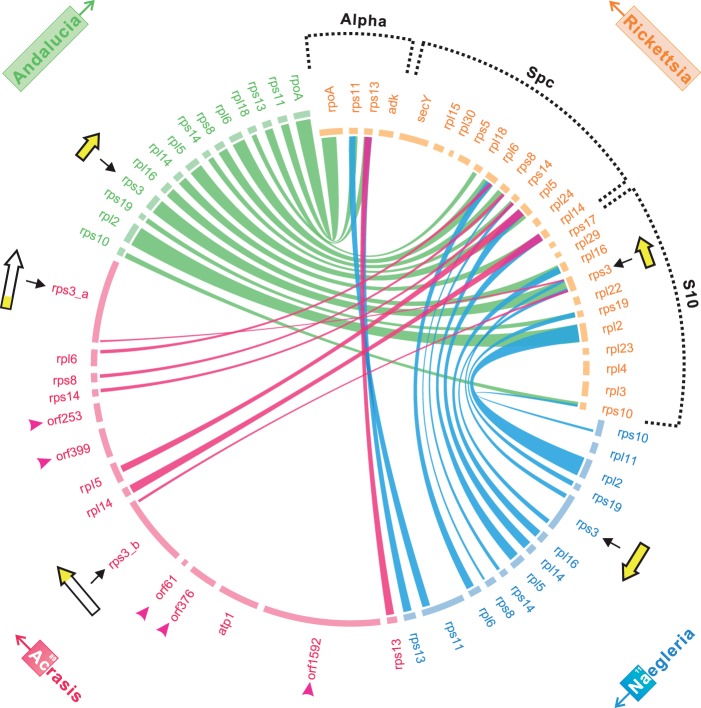
A comparison of mtDNA gene order for the largest r-protein synteny block. The same block is compared with the generally contiguous S10, spectinomycin (Spc) and Alpha operons of α-proteobacteria as determined by BLASTp (E value < 1 e−10) against Rickettsia prowazekii genome (NC_000963). The locations of the rps3 genes within each synteny cluster are indicated with schematic models. The unknown ORFs in Acrasis kona are indicated with fuchsia triangles.